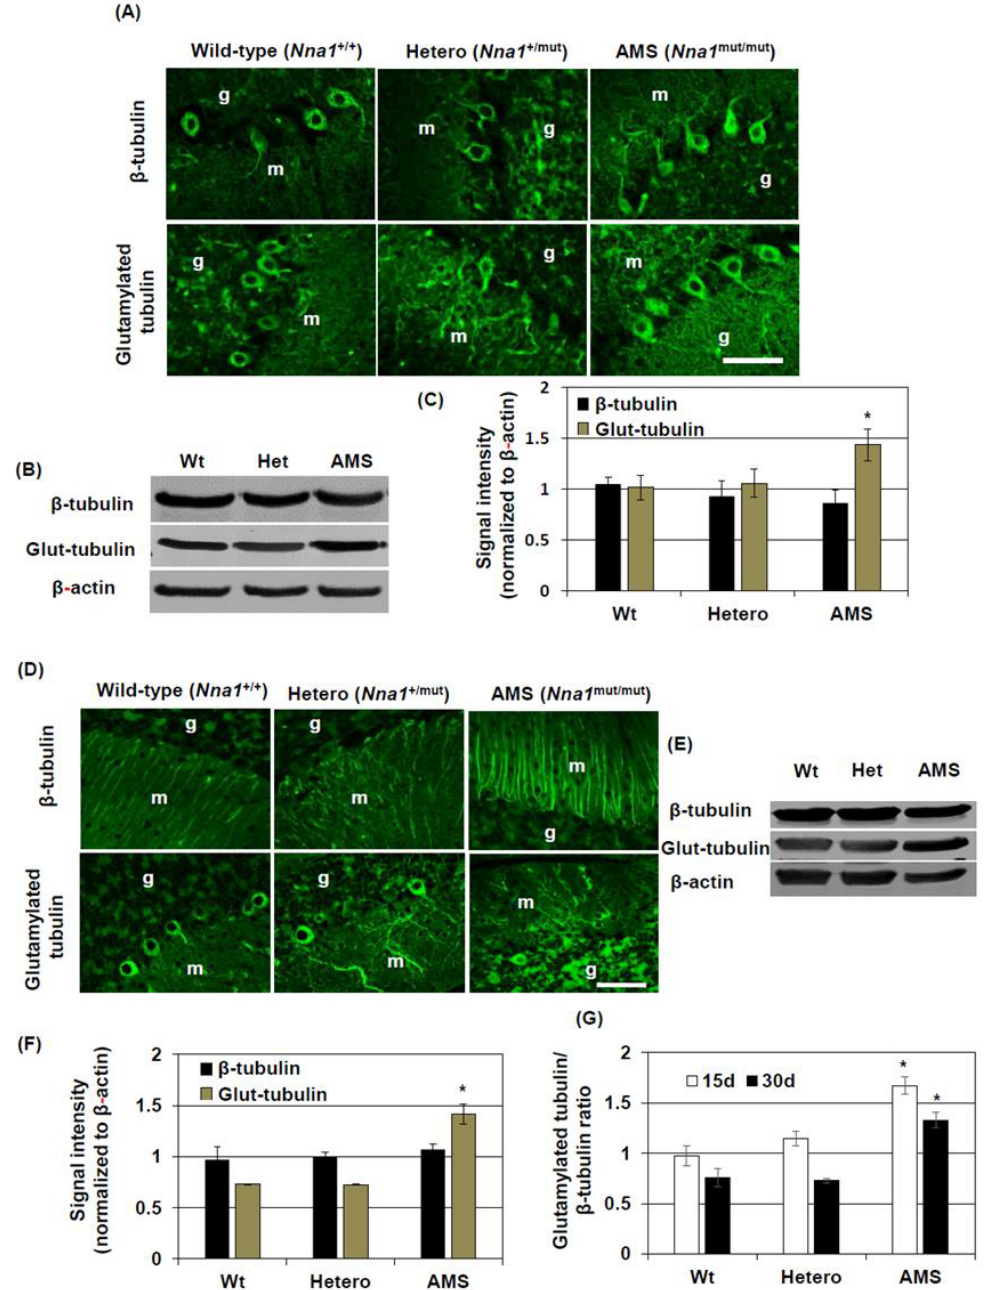
Figure 6. β -tubulin protein expression and modification in the cerebellum of AMS mice: Protein expression and glutamyla- tion of β -tubulin in the cerebellum were evaluated using immunofluorescence staining and Western blotting. Representative photomicrographs of β -tubulin and glutamylated tubulin (Glut-tubulin) immunofluorescence staining of the cerebel- lum of wild-type, Nna1 mutation heterozygous (Hetero), and AMS mice at 15 ( A ) and 30 ( D ) days of age are shown. m = molecular layer, g = granular layer. β -tubulin and glutamylated tubulin levels were further evaluated by Western blotting. Representative Western blotting results of the cerebellum of wild-type (Wt), Nna1 mutation heterozygous (Het), and AMS mice at 15 ( B ) and 30 ( E ) days of age are displayed. β -actin was used as a loading control. The levels of β -tubulin and glutamylated tubulin were quantified by densitometry, and the quantified data normalized to β -actin of mice at an age of 15 ( C ) and 30 ( F ) days are shown. The ratio of glutamylated tubulin to β -tubulin are shown in ( G ). Numerical data are presented as averages ± SD of 5 mice in each group. Statistical significance is denoted as follows: * p < 0.05 vs. wild-type. Scale bar = 50 µM.